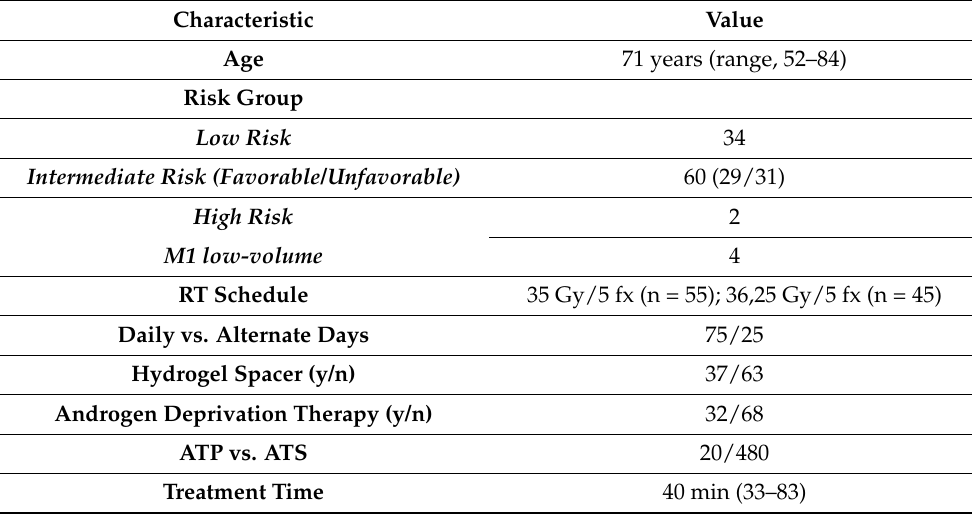
Table 1. Patients’